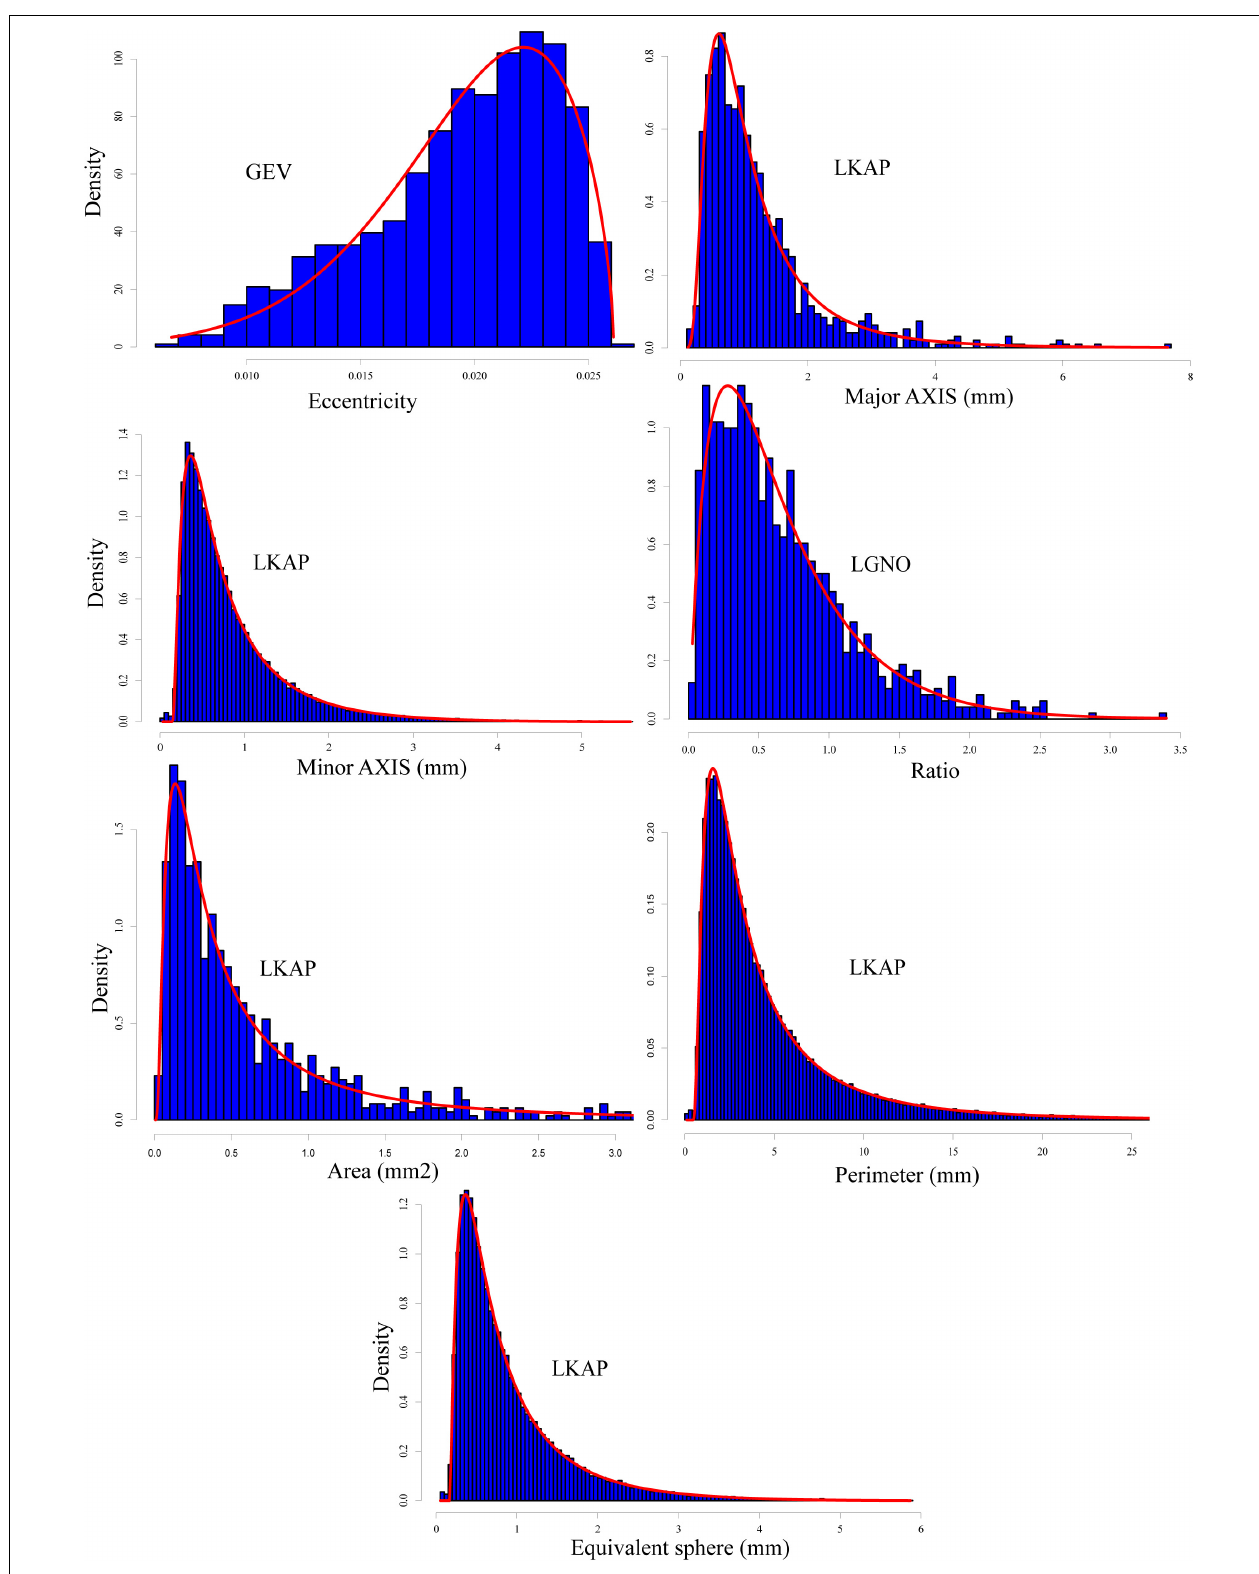
FIGURE 7 | Same as Figure 3 but for all snow grains classified as “precipitation particles” with a total of 967 grains.